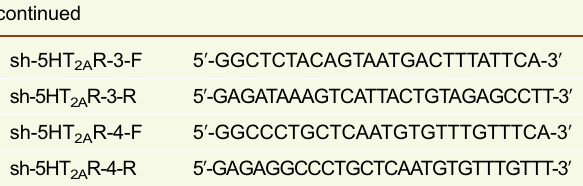
Figure 5. Drug-drug interaction of PBZ with selected different classes of anti-HCV drugs. Huh7.5.1 cells infected by HCVcc were treated with various concentra- tions of PBZ, IFN- α (A), ribavirin (B), sofosbuvir (C), boceprevir (D), telaprevir (E), daclatasvir (F) and cyclos- porin A (G) alone, or in combinations at the indicated concentrations for 48 h. Antiviral activities were deter- mined by measuring the reduction of luciferase activity in the cells. Differential surface plot at the 95% con fi dence level (CI) were calculated and generated by using MacSynergy II for the drug – drug interaction in the right panels. The 3-dimensional plot represents the differences between the actual experimental effects and the theoret- ical additive effects at various concentrations of two compounds in combination. Peaks above the theoretical additive plane indicate synergy. Only statistically signi fi - cant (95% CI) differences between the two compounds were considered at any given concentration. The level of synergy is represented by the log volume values, and color-coded automatically. The level of synergy was de fi ned in MacSynergy as moderate synergy (5 ≤ log volume < 9) and strong synergy (log volume ≥ 9). Results are graphed as the mean ± SD for duplicate